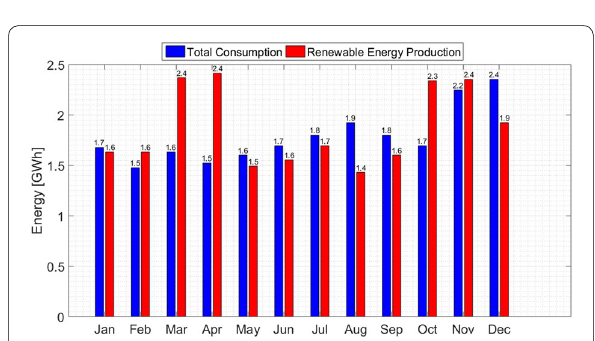
Fig. 6 Estimated total renewable energy emission and monthly consumption for 2018 in Santa